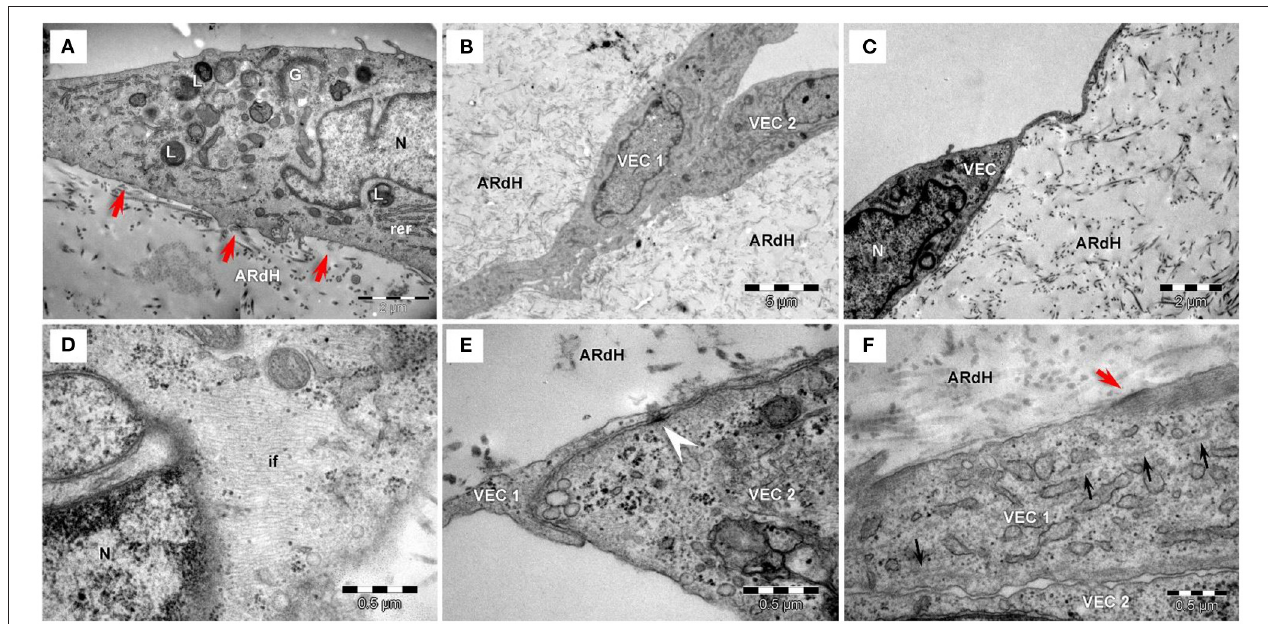
FIGURE 4 | Transmission electron microscopy of VEC exposed to high glucose conditions for 48h (A) or 7 days (B–F) on the hydrogel construct. (A) VEC in hydrogel (ARdH) show endothelial protrusions, a developed prominent Golgi system (G), rough endoplasmic reticulum (rer), numerous lysosomes (L). Caveolae are visible on the plasma membrane. Focal adhesion junctions (red arrows) connect VEC to the hydrogel. (B) VEC (1, 2) present extended bodies in the hydrogel and with more numerous organelles and prominent cytoplasm. (C) VEC with a smaller body and heterochromatic nucleus. (D) Abundant intermediate filaments (if) are distributed throughout the cytoplasm. (E) Adherens junctions (arrowhead) connect two different VEC ( 1, 2). (F) Intercellular junctions between VEC (1, 2) are less developed. Focal adhesions (red arrows) connect VEC with ARdH hydrogel. Microtubules (small black arrows) are visible into the